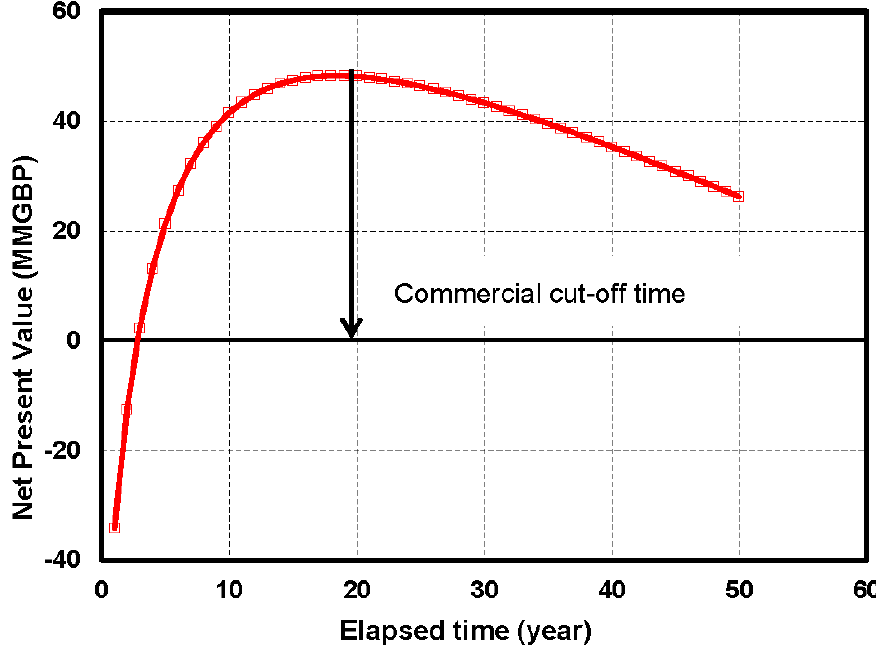
Figure 1. Selection of commercial cut off for a pre-specified value of Heterogeneity Impact Factor (HIF).